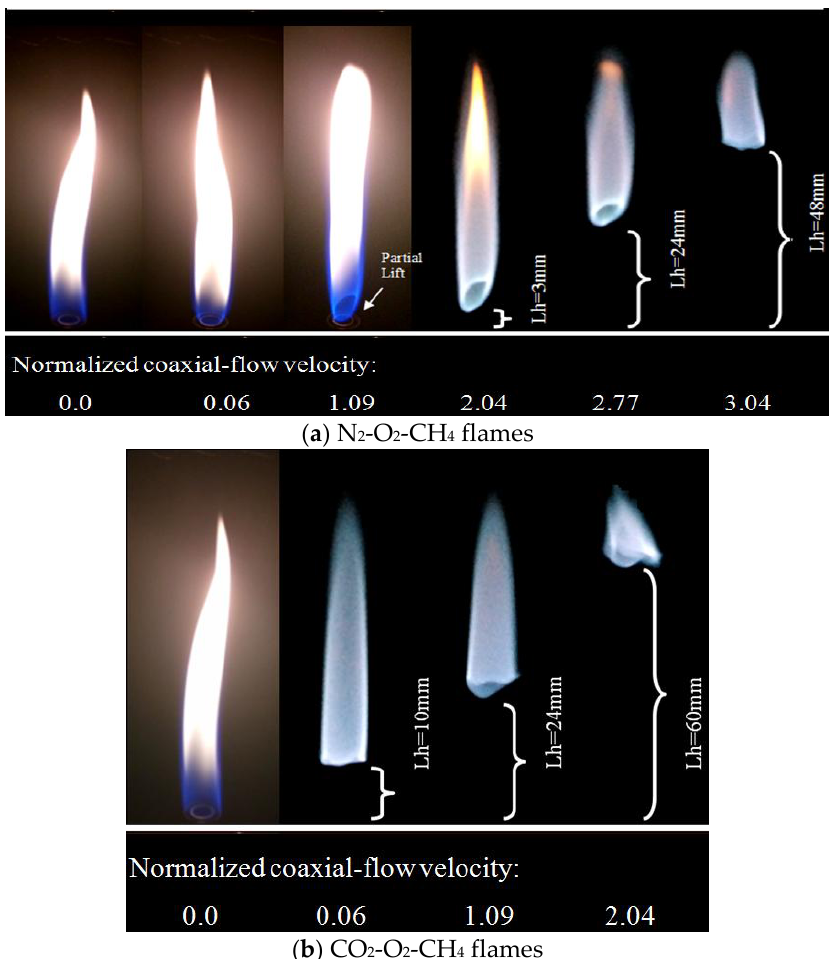
Figure 2. Flame photos against increasing coaxial-flow velocity at β = 21%.